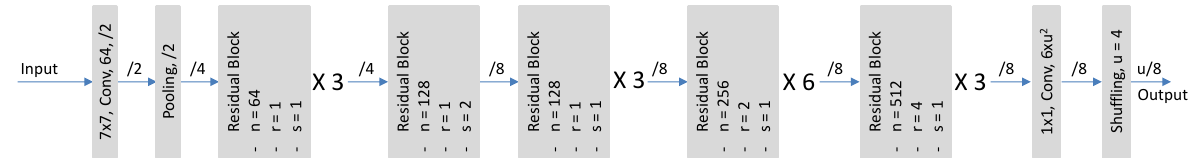
Figure 3. The overall structure of our Residual Shuffling Convolutional Neural Network (RSCNN): the symbol “/2” in the convolutional block refers to the stride of the convolutional layers and symbols like “/2” upon arrows indicate that the resolution is reduced to half of the input in length, while symbols like “X3” after a residual block indicate that the corresponding block is repeated three times.